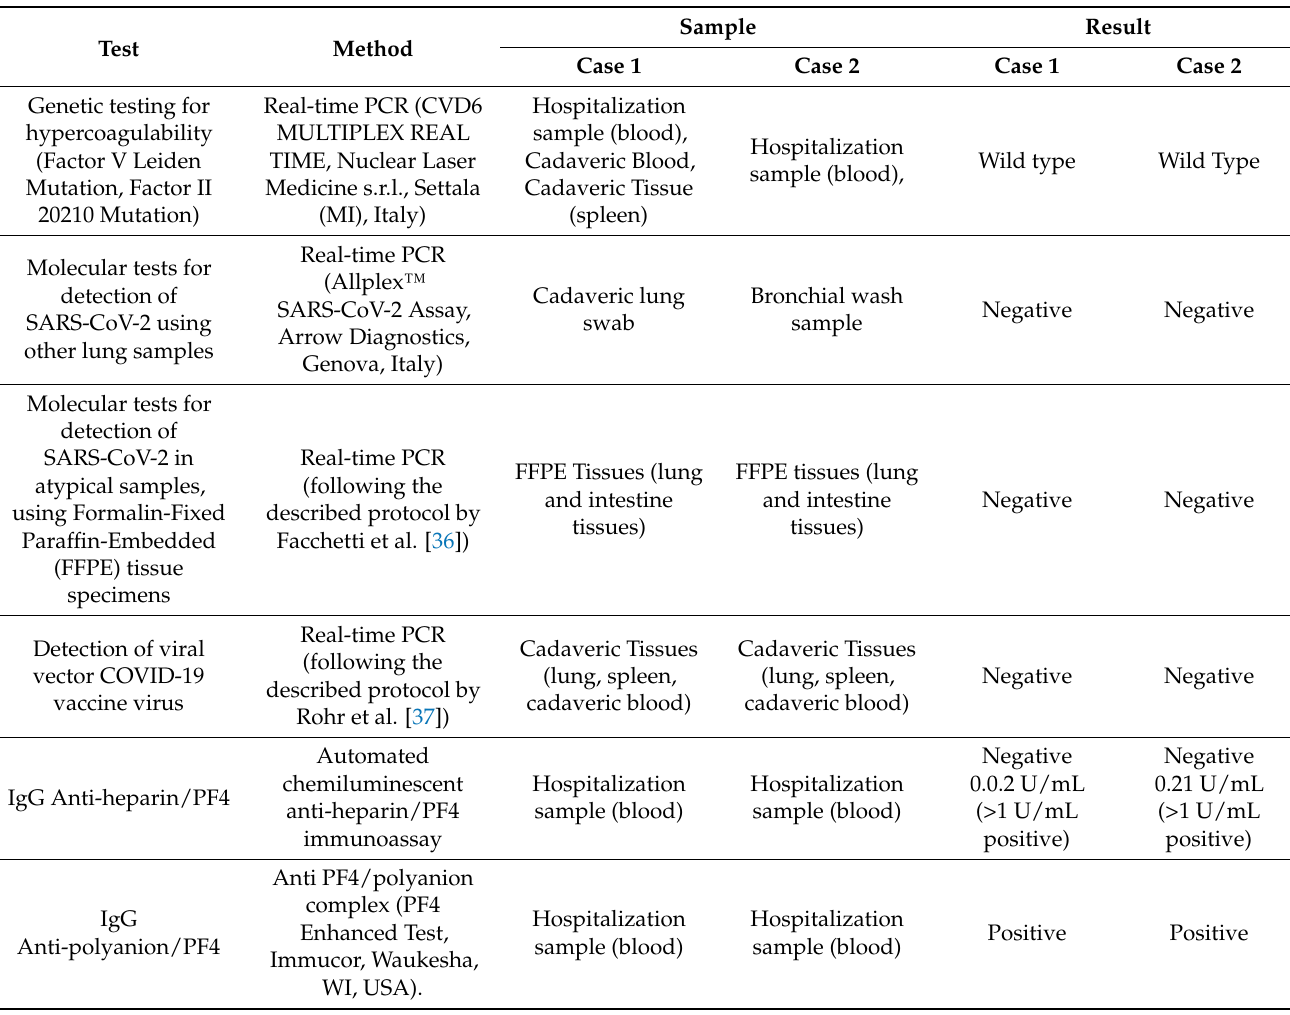
Table 2. Summary of main tests performed relative to each proposed case. The data obtained from medical records are not